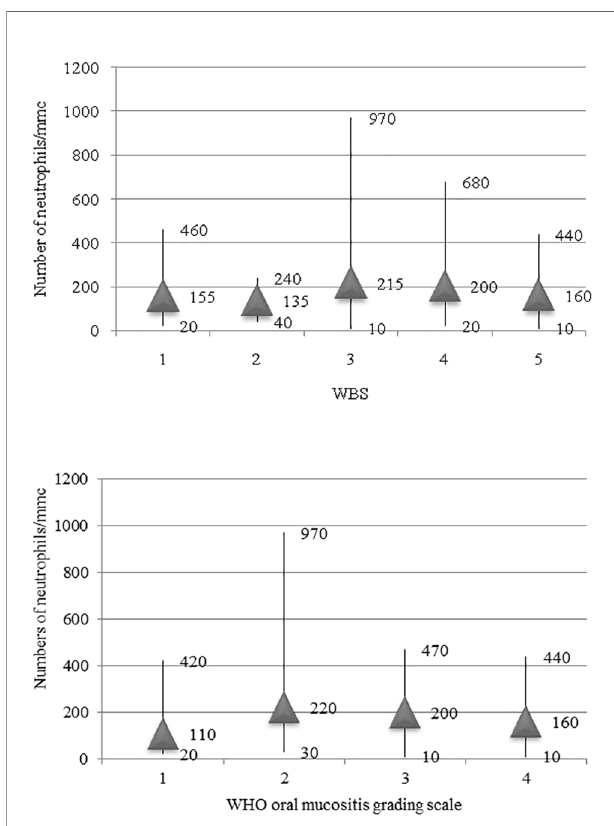
FIGURE 3 | Relationship between the minimum number of neutrophils observed during the episode of mucositis and the grade of mucositis according to WBS and WHO oral mucositis